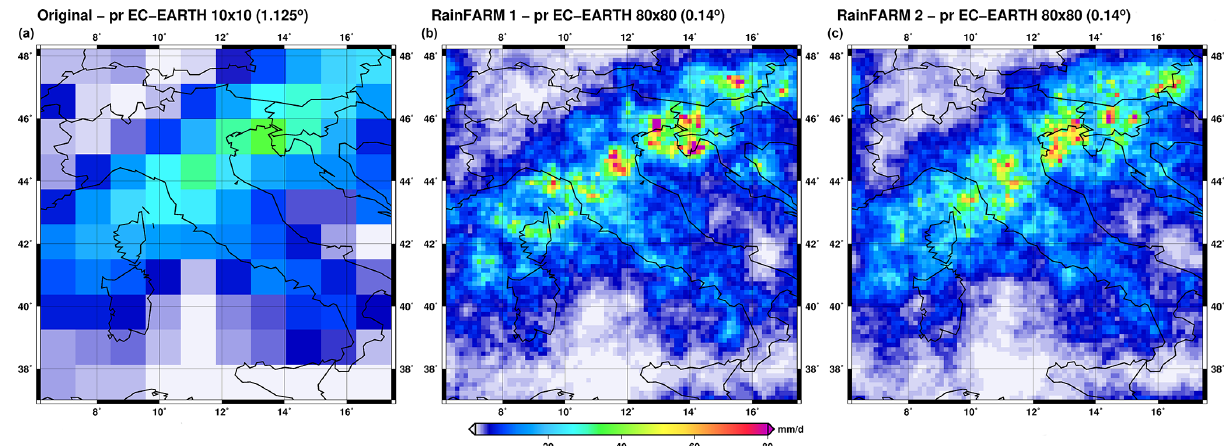
Figure 17. (a) Example of daily accumulated precipitation from the EC-EARTH CMIP5 model on a specific day (artificial date, not a real precipitation event), downscaled using RainFARM from its original resolution (1.125 ◦ ). (b, c) Two stochastic realizations for increasing the spatial resolution by a factor of 8 to 0.14 ◦ ; a fixed spectral slope of s = 1 . 7 was used. The data were produced by recipe_rainfarm.yml , but this plot was not produced by ESMValTool – the recipe output is NetCDF